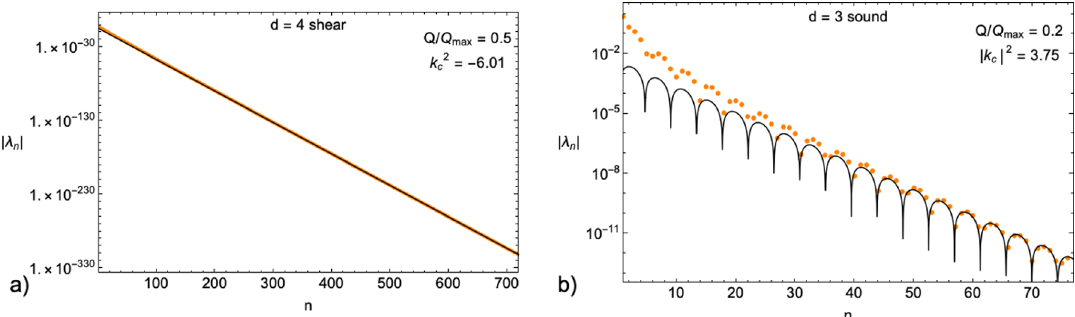
Figure 4 . Perturbative coe(cid:14)cients of the small- k expansion of the dispersion relation of the shear mode for ~ Q = Q=Q max = 0 : 5 ; d = 4 (panel a) and the sound mode for ~ Q = Q=Q max = 0 : 2 ; d = 3 (panel b). By (cid:12)tting appropriately these coe(cid:14)cients, as depicted by the solid black lines, we are able to extract the corresponding radius of convergence to be k 2 k 2 = 3 : 75 e (cid:6) i(cid:25) 0 : 054 in panel c